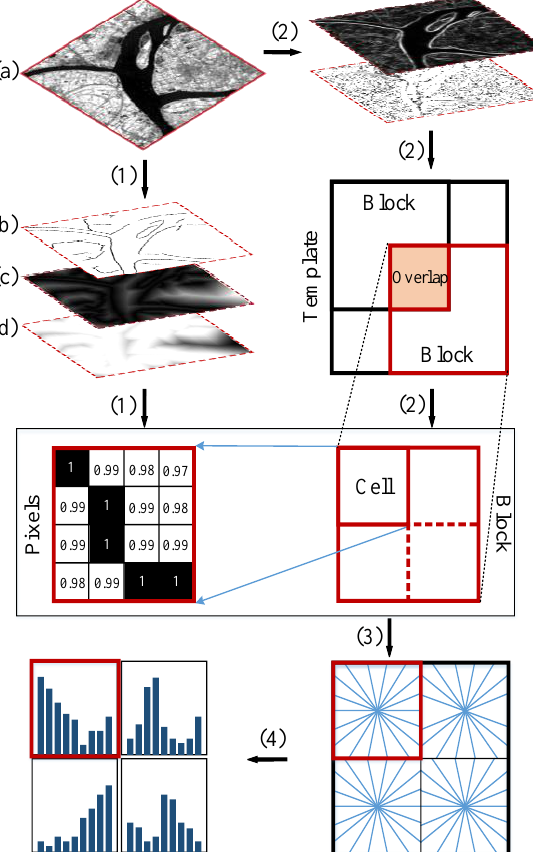
Fig.3 Main processing chain for M-HOPC